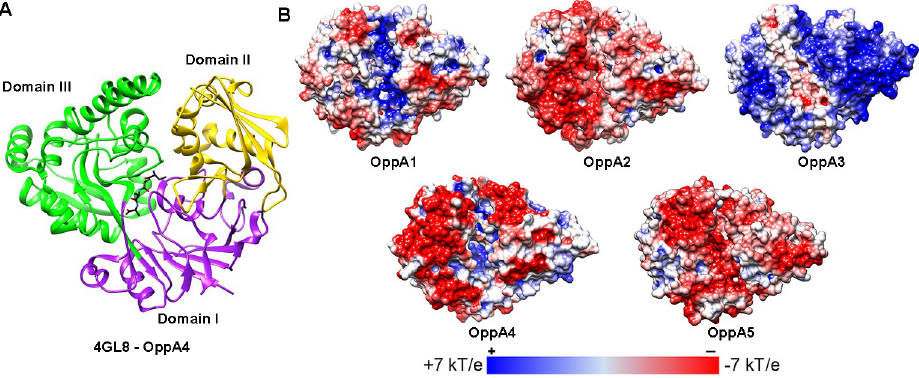
Fig 8. The binding pockets of OppA1-5 demonstrate variations in electrostatic distribution. (A) Ribbon model of OppA4 crystal structure (PDB: 4GL8) [26] showing domains I (purple–hinge region), II (yellow), and III (green) and the Ala 4 liganded peptide (black). (B)Electrostatic distributions unliganded (open) OppA1-5, modeled against unliganded E . coli OppA (PDB: 3TCH) [24]. Electrostatic models have been rotated 45˚ on the z-axis to show the permease-binding regions (region framing the binding site as clearly seen on the positively charged surface of OppA3) or the binding pockets (clearly distinguished as the positively charged pocket along the center of OppA1). Figure was adapted from Groshong et al .